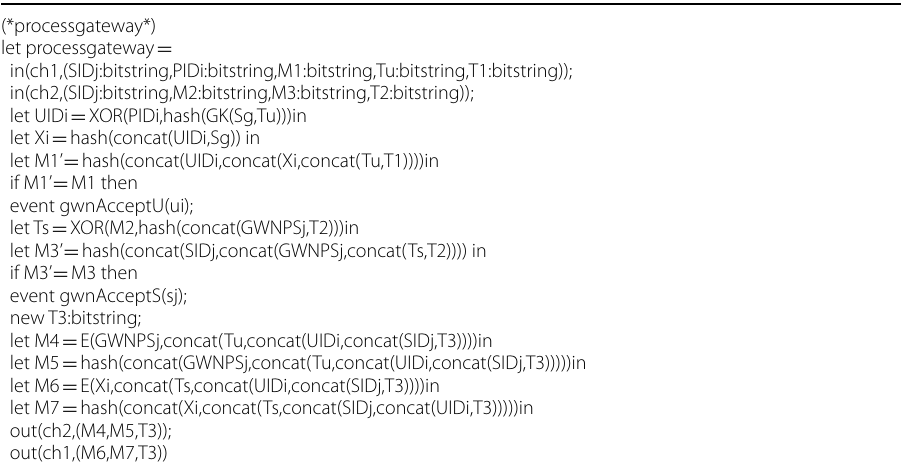
Table 5 Gateway node simulation